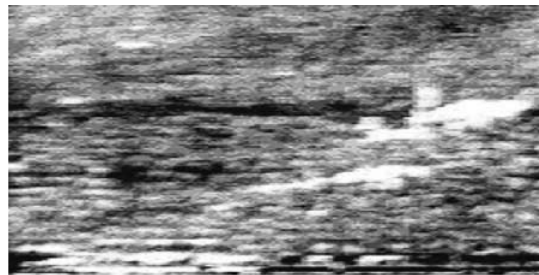
Fig. 3 AFM Pictures of the Nanoparticles.